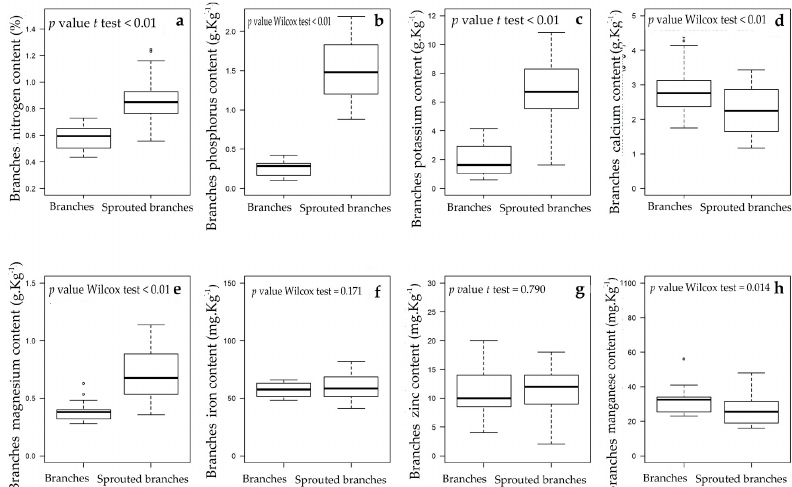
Figure A5. Box plot and p values of paired mean tests comparing branch chemical attributes data for “reference” and “regrowth” material collected by sequential management of above ground rosewood mass in the three study areas. ( a ) Nitrogen; ( b ) Phosphorus; ( c ) Potassium; ( d ) Calcium; ( e ) Magnesium; ( f ) Iron; ( g ) Zinc and; ( h )